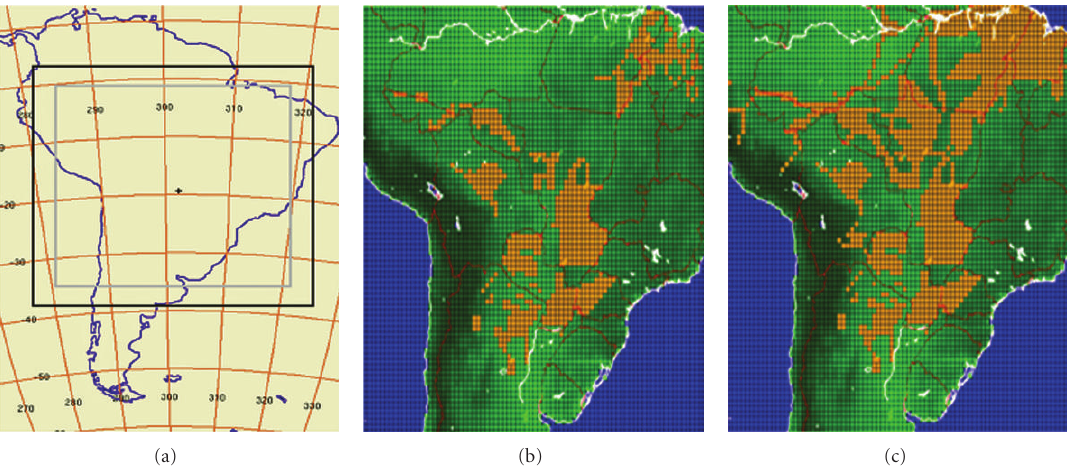
Figure 1: Model domain over central South America. Deforestation (land-use/change scenarios selected for the study. The areas shown in orange represent the land-use/change from forests/savannas to crop fields. The map (b) shows observed land-use changes up to 2002 (MAP1), while the map (c) shows a hypothetical vegetation map for 2030 (MAP2) based on land-use change